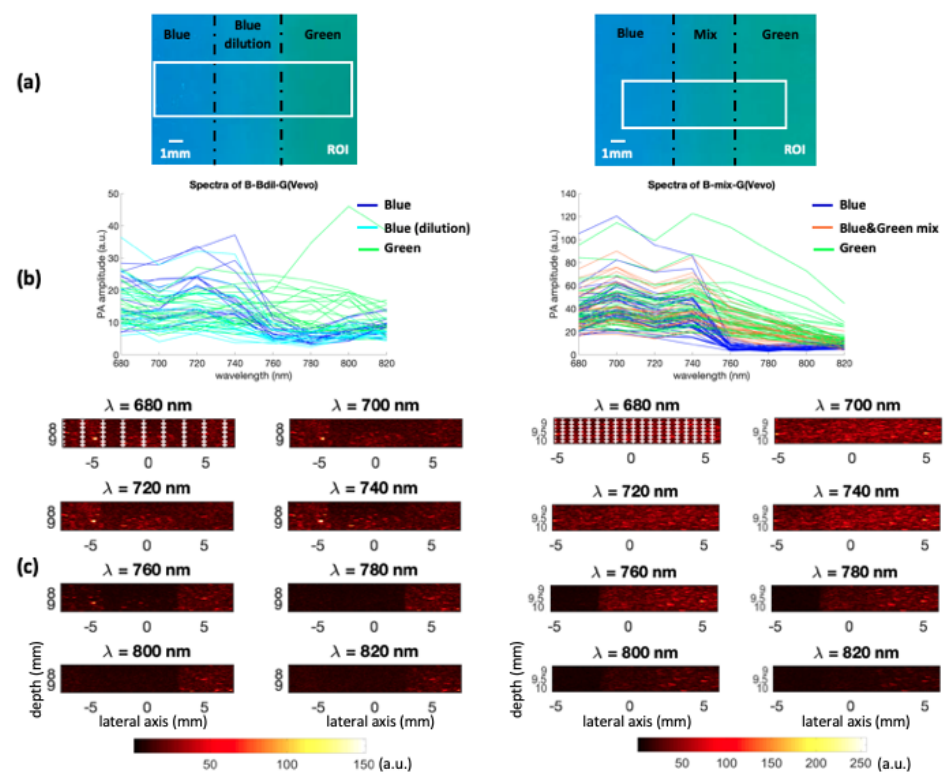
Figure 4. ( a ) Left: Blue/0.53 blue dilution/green colored phantom. Right: Blue/0.42 blue & 0.67 green mix/green colored phantom. ( b ) Spectra of each region of interest. Each spectrum corresponds to a specific pixel. These pixels are highlighted on the images (c) at λ = 680 nm. (a.u., arbitrary units) ( c ) Left: The B-Bdil-G(Vevo) dataset (mean value over all 8 wavelengths: 12.05 a.u.). Right: The B-mix-G(Vevo) dataset (mean value over all 8 wavelengths: 26.72 a.u.). The image axes are in